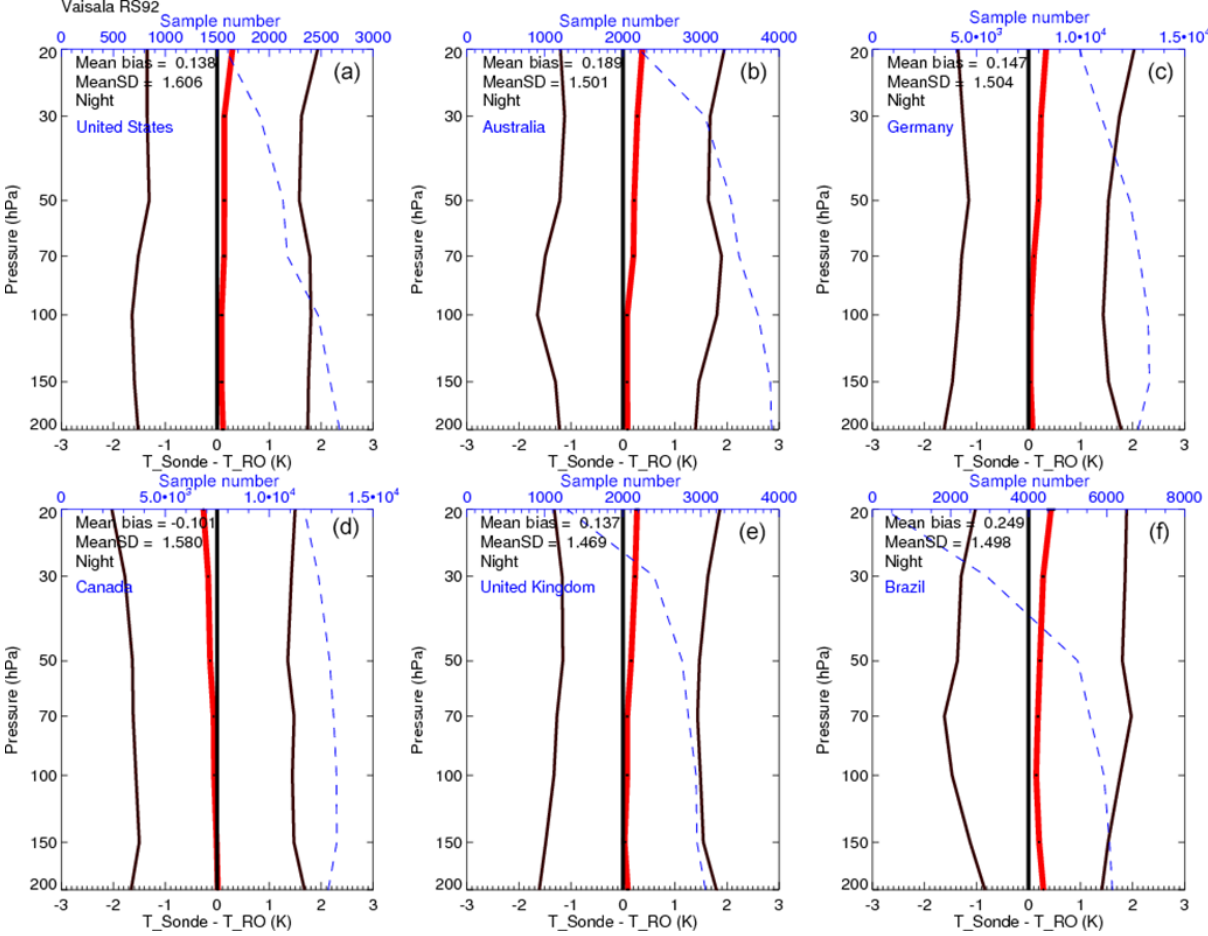
Figure 4. Comparisons of temperature between RS92 and RO for nighttime over (a) United States, (b) Australia, (c) Germany, (d) Canada, (e) United Kingdom, and (f)